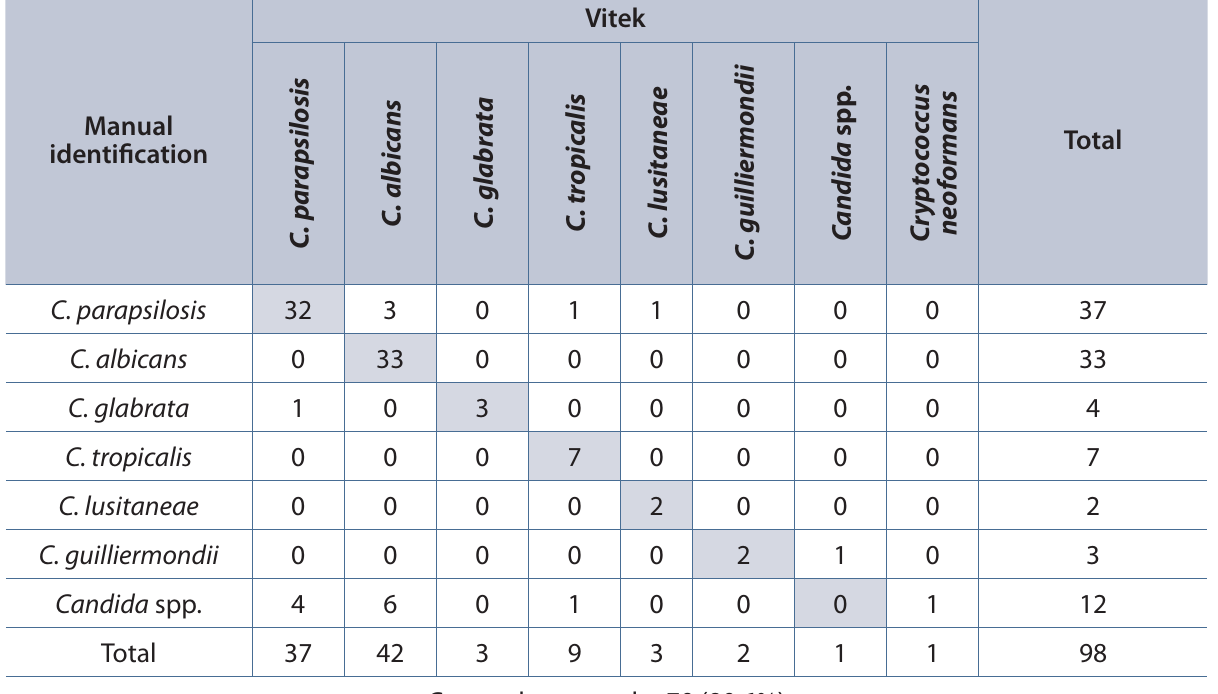
Manual identification